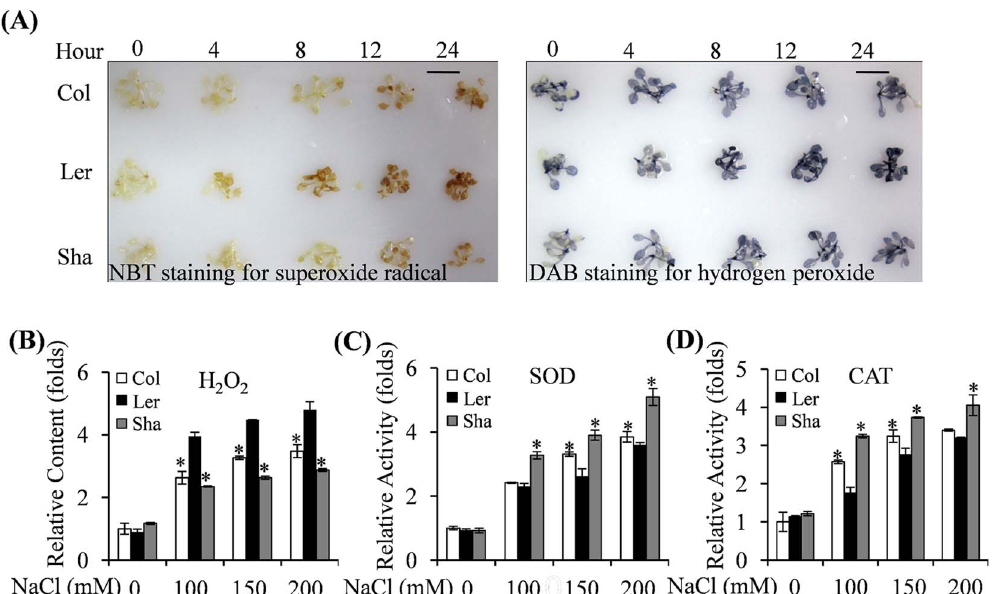
Figure 3. Quantitative comparison of superoxide contents and antioxidant enzyme activities (SOD and CAT) among Col, Ler and Sha after salt stress treatment. Two-week-old plants were started to be treated with the indicated concentrations of NaCl for 10 days before measurement in (B), (C) & (D). The values indicated means + SEs of two independent experimental repeats in (B), (C) & (D) (n=15). * indicated significant difference with P , 0.05 (t-test) in relative to Ler. (A) Visualization of superoxide radical and hydrogen peroxide detected by NBT and DAB staining. Detections have been done on 2-week-old MS-grown plants subjected to subsequent treatment with 200 mM NaCl for the indicated time. Bar=1 cm. (B) Changes in H 2 O 2 content were analyzed with different salt treatment. (C) Changes in SOD activity were analyzed with different salt treatment. (D) Changes in CAT activity were analyzed with different salt treatment.